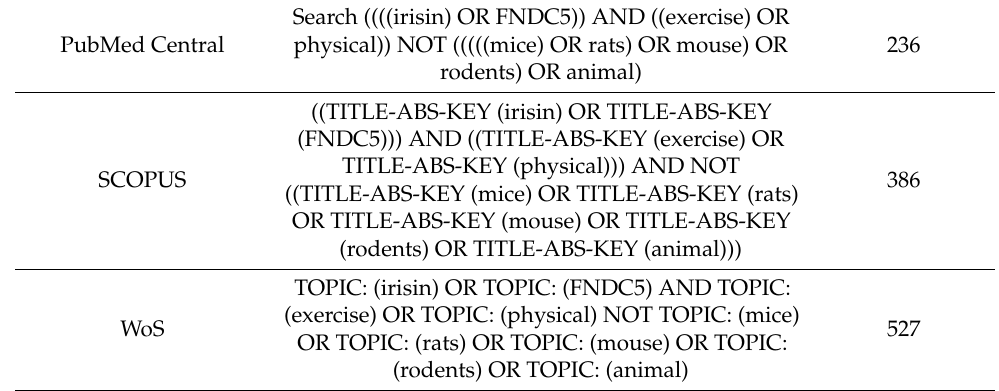
Table 1. Search results from electronic